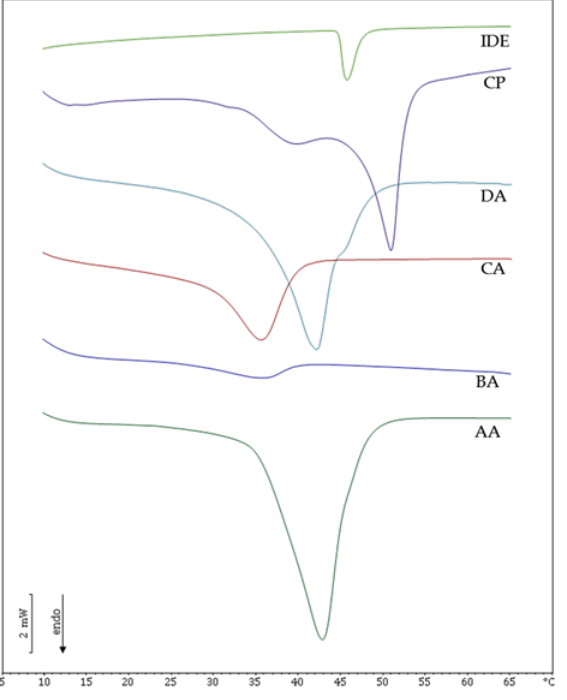
Figure 2. DSC curves of cetyl palmitate (CP), idebenone (IDE) and formulations AA, BA, CA and DA.